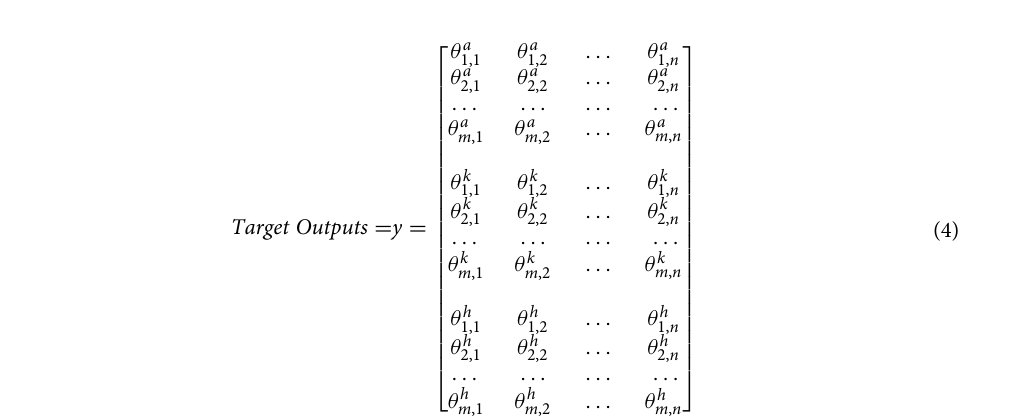
Figure 8. WNN architecture. The WNN consists of two layers namely; input layer, hidden layer, and output layer. k , i , and j denote the number of input, hidden, and output nodes respectively. The ω kj is the weight between input node k and output node j . Similarly, ω ij is the weight between hidden layer node i and output node j . ω (ξ) ki is the translation and ω (ς) ki is the dilation between hidden layer node i and input node k . b j is the bias of j th output node. The hidden layer nodes are activated by the Mexican hat wavelet function. The output layer nodes are activated using the linear activation